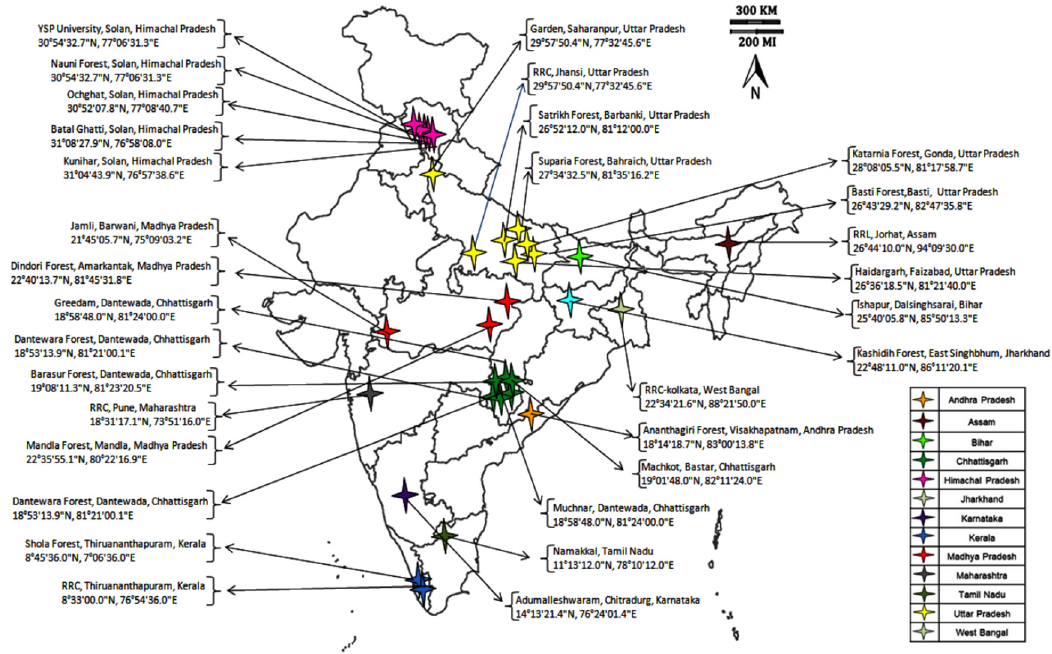
ff erent geographical regions of India.